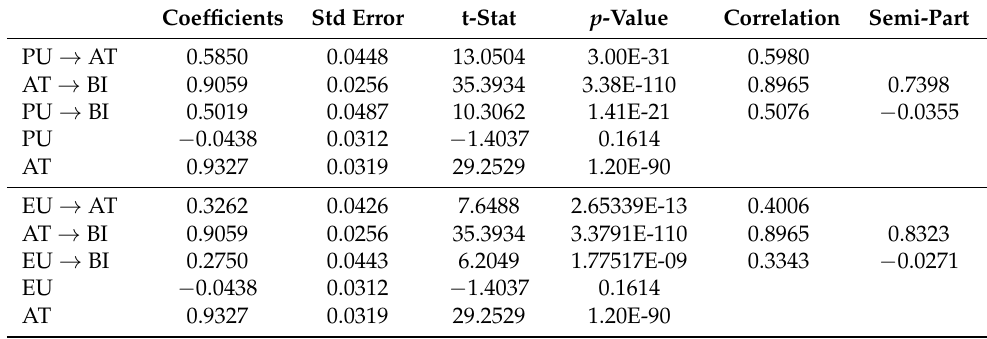
Table 14. Mediation Analysis (PU affects the outcome of BI indirectly through mediator